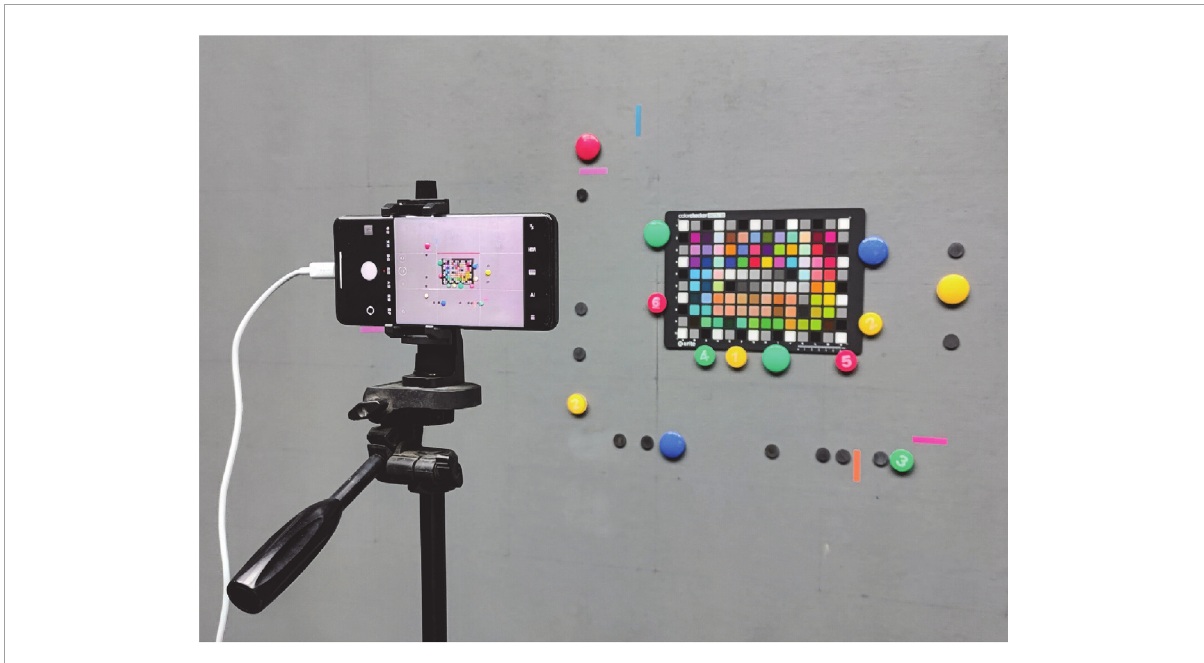
FIGURE2 Mobile phone imaging scene.